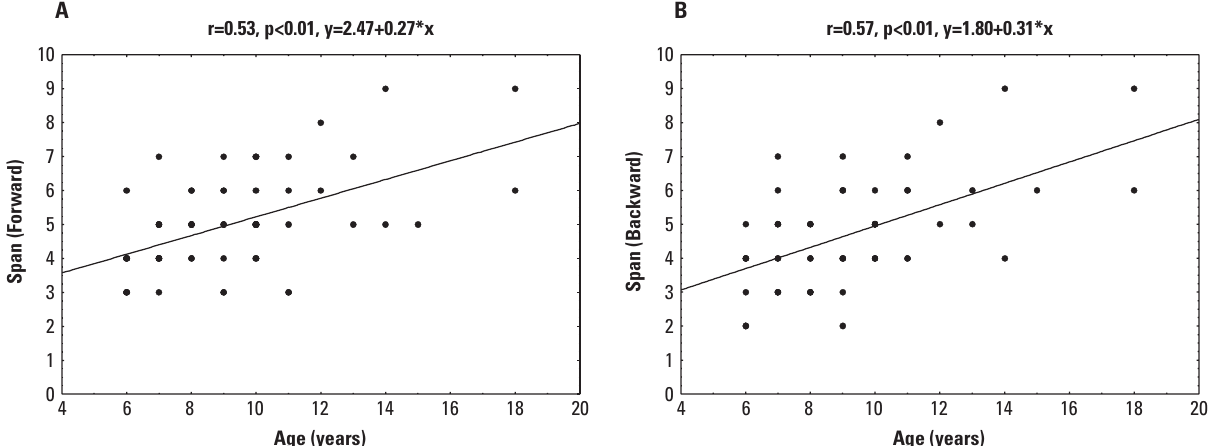
Figure 1. Regression lines representing Spatial Span Performances according to age, Pearson’s coefficient (r), p-values, and regression equations. [A] forward trial and [B] backward